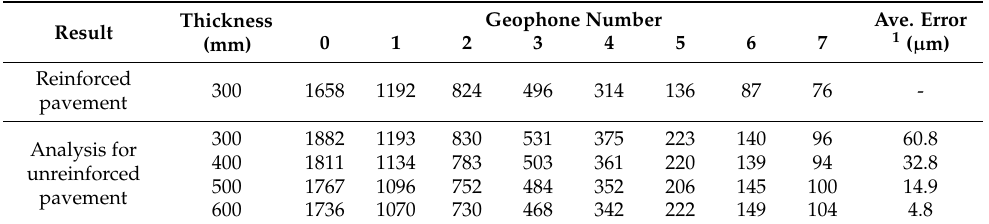
Table 4. Back-calculated elastic modulus results for the unreinforced pavement program according to different